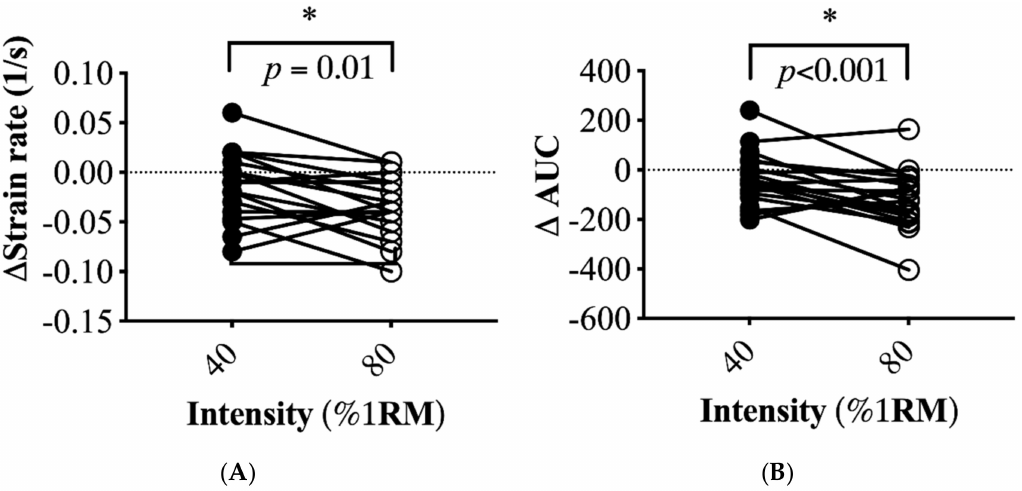
Figure 3. The changes of strain rate ( A ) and AUC ( B ) after 40 and 80%1RM. * = vs.